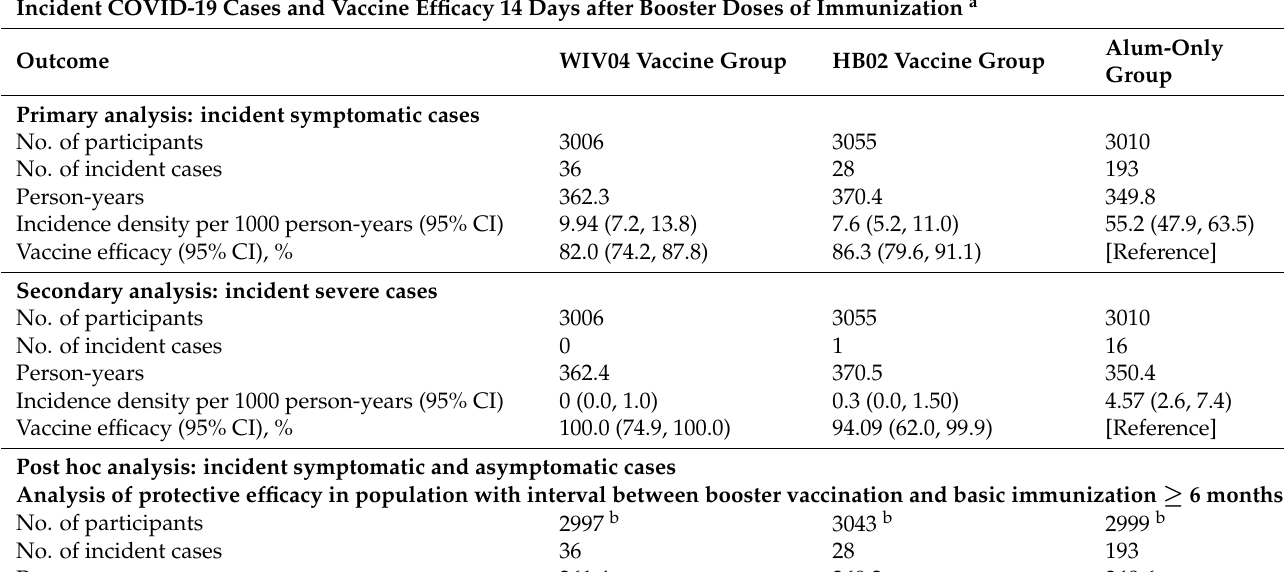
Table 2. Efficacy of 2 Inactivated Vaccines Against Symptomatic